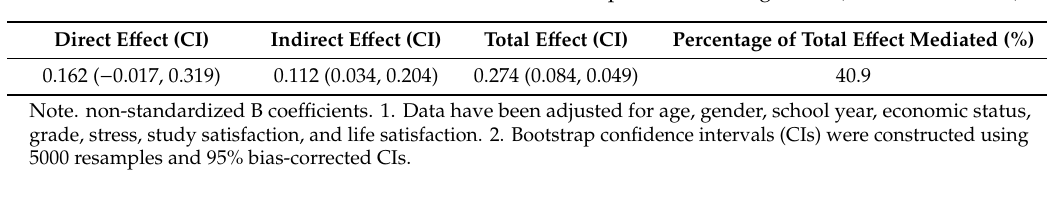
Table 4. Total, direct, and indirect e ff ects of motivation on post-traumatic growth (mediation